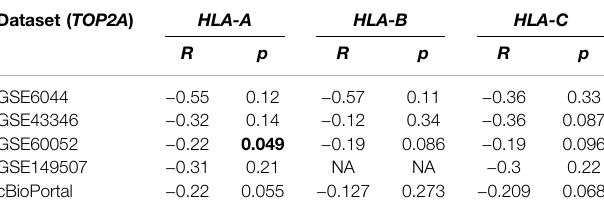
Bold font indicates statistically signi fi cant p value ( < 0.05).